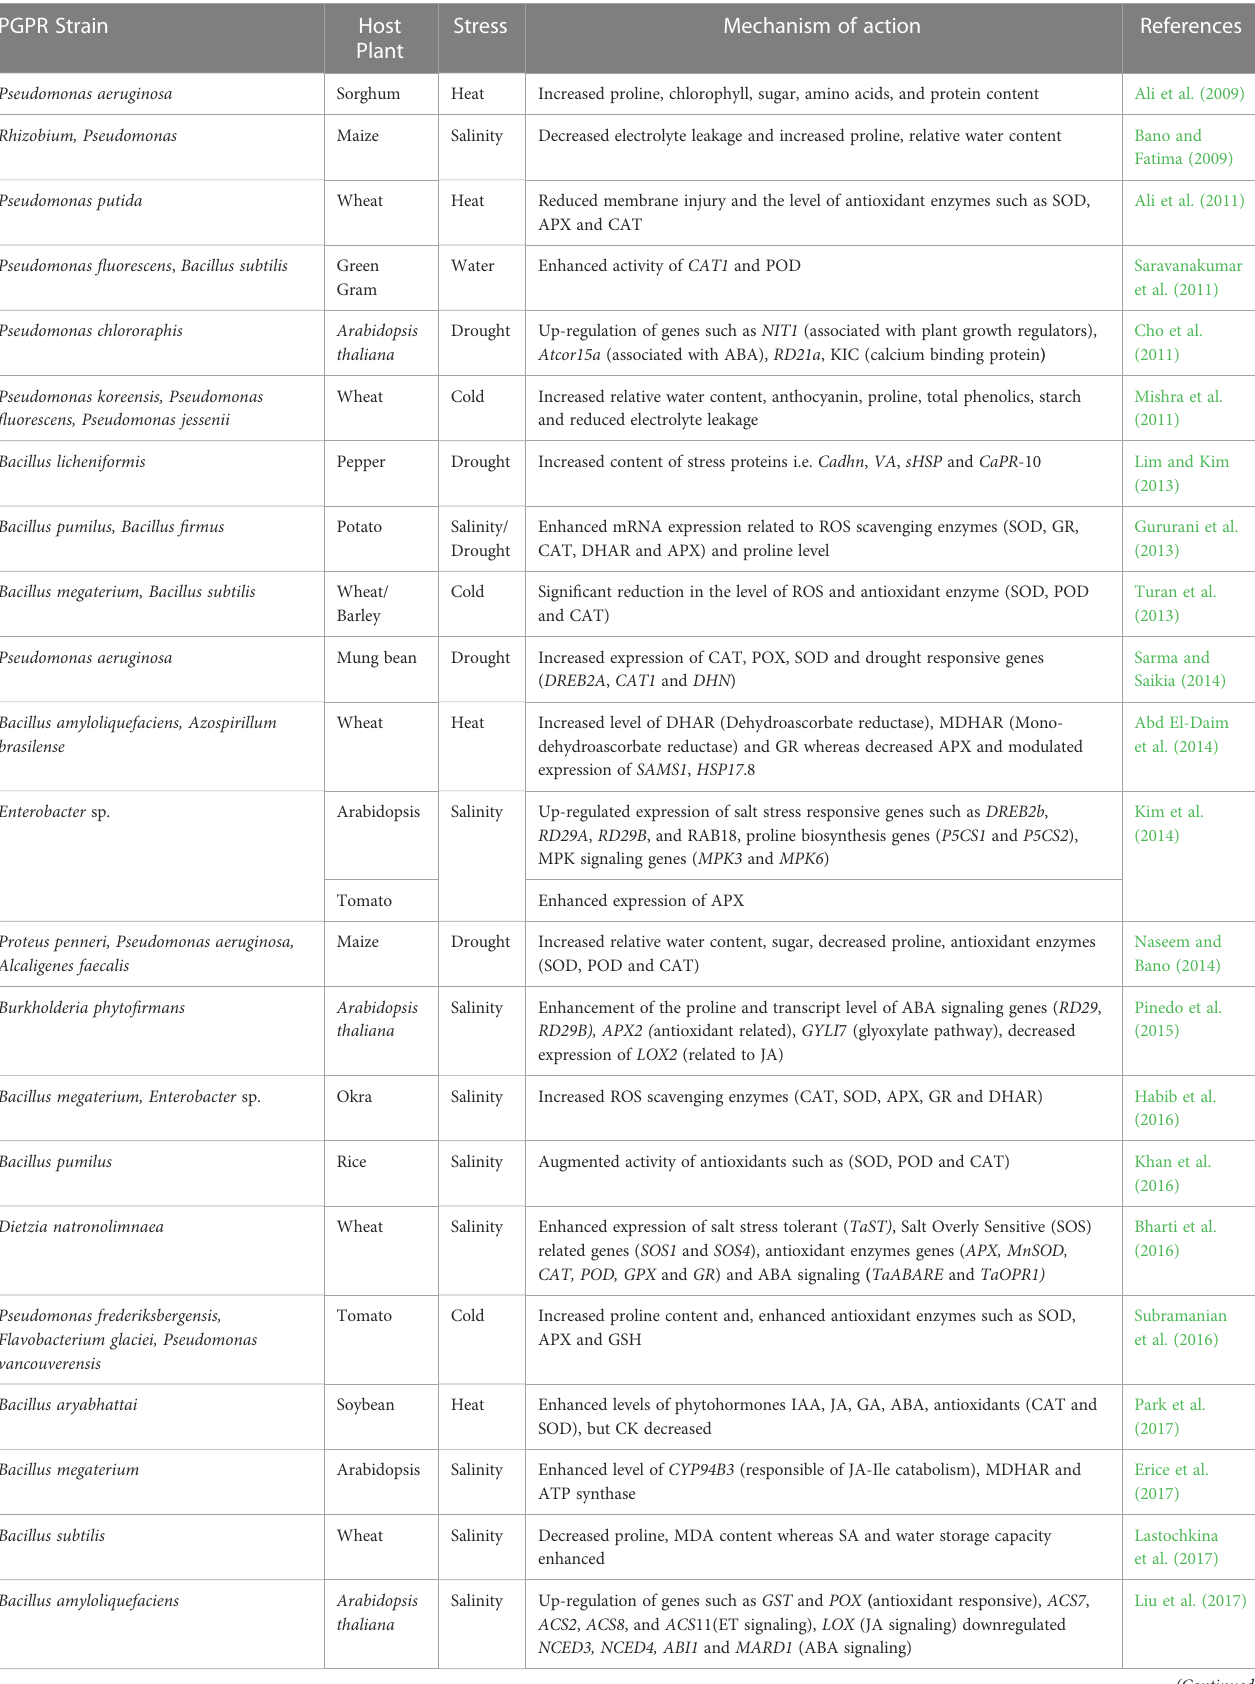
TABLE 1 PGPRs along with their mode of action in combating abiotic